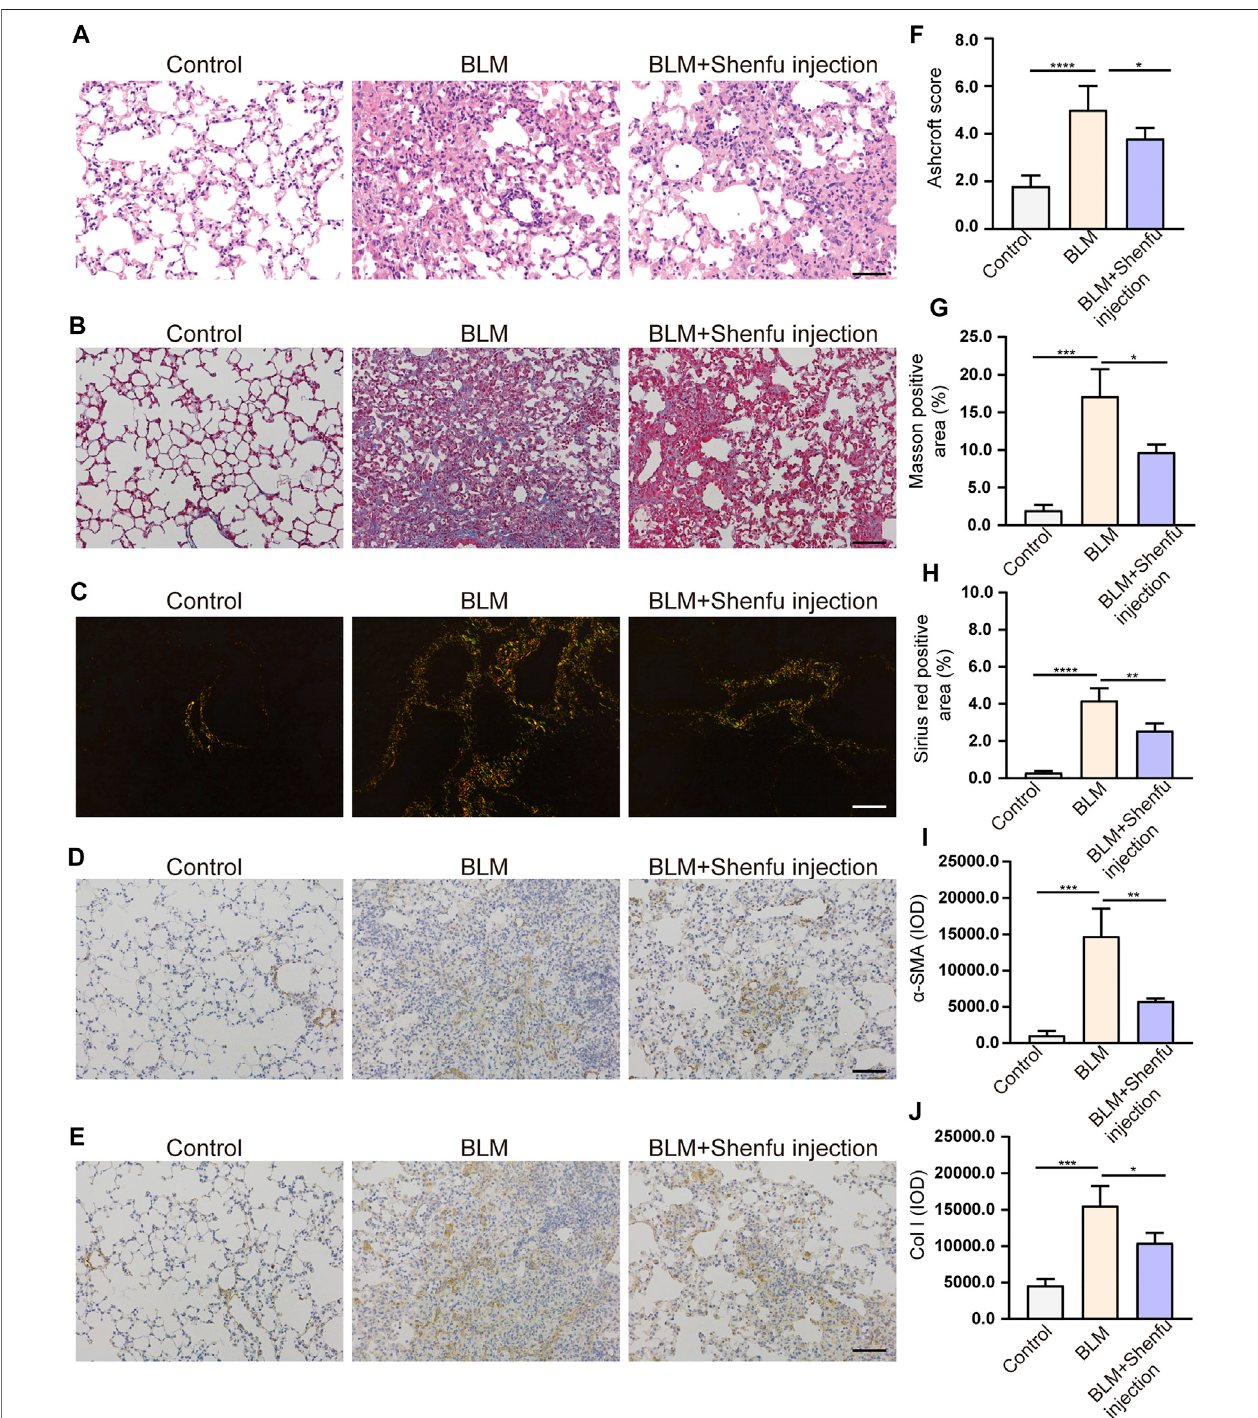
FIGURE3| Shenfuinjectionalleviatespulmonary fi brosis.RepresentativephotomicrographsofH&Estaining (A) ( n (cid:1) 5),Masson ’ strichromestaining (B) ( n (cid:1) 3)and Siriusredstaining (C) ( n (cid:1) 3).Representativeimmunohistochemistryphotomicrographsof α -SMA (D) ( n (cid:1) 3)andcollagenI (E) ( n (cid:1) 3).Quanti fi cationofpulmonary fi brosis by Ashcroft score (F) , Masson positive area (G) , Sirius red positive area (H) , α -SMA positive signals (I) and collagen I positive signals (J) . Scale bar: 100 μ m. The results are expressed as mean ± SD. **** p < 0.0001; *** p < 0.001; ** p < 0.01; * p < 0.05. IOD, integrated optical density.